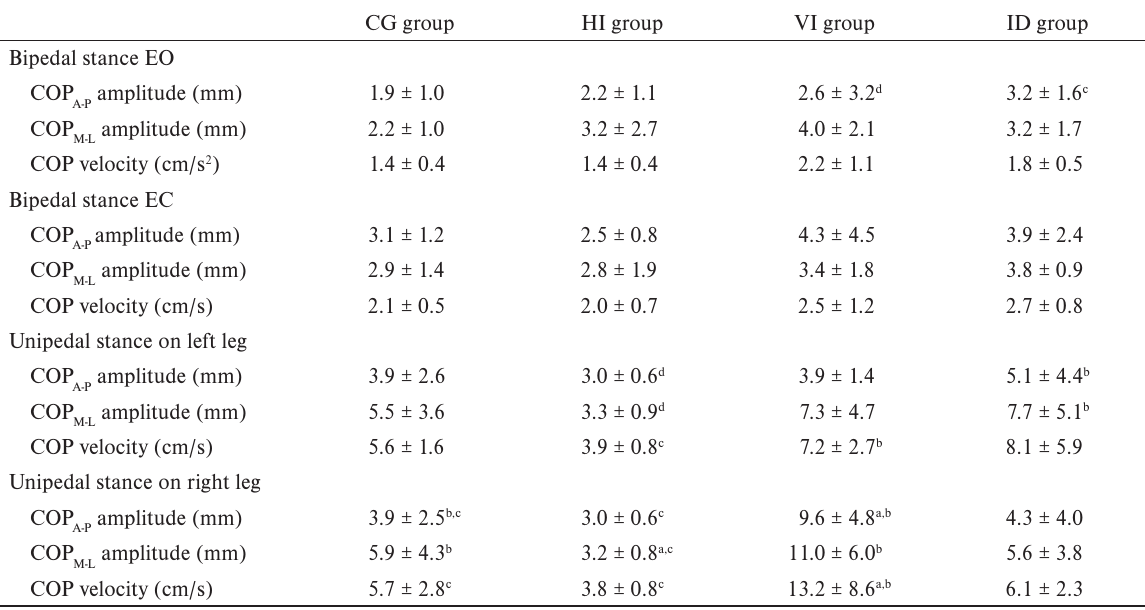
Table 2 Mean and standard deviation of the COP results obtained for all